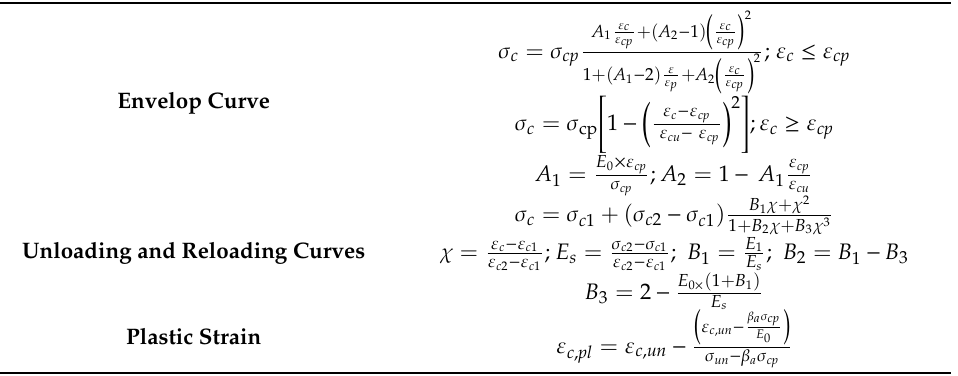
Table 2. Constitutive model for masonry under cyclic compression: Crisafulli